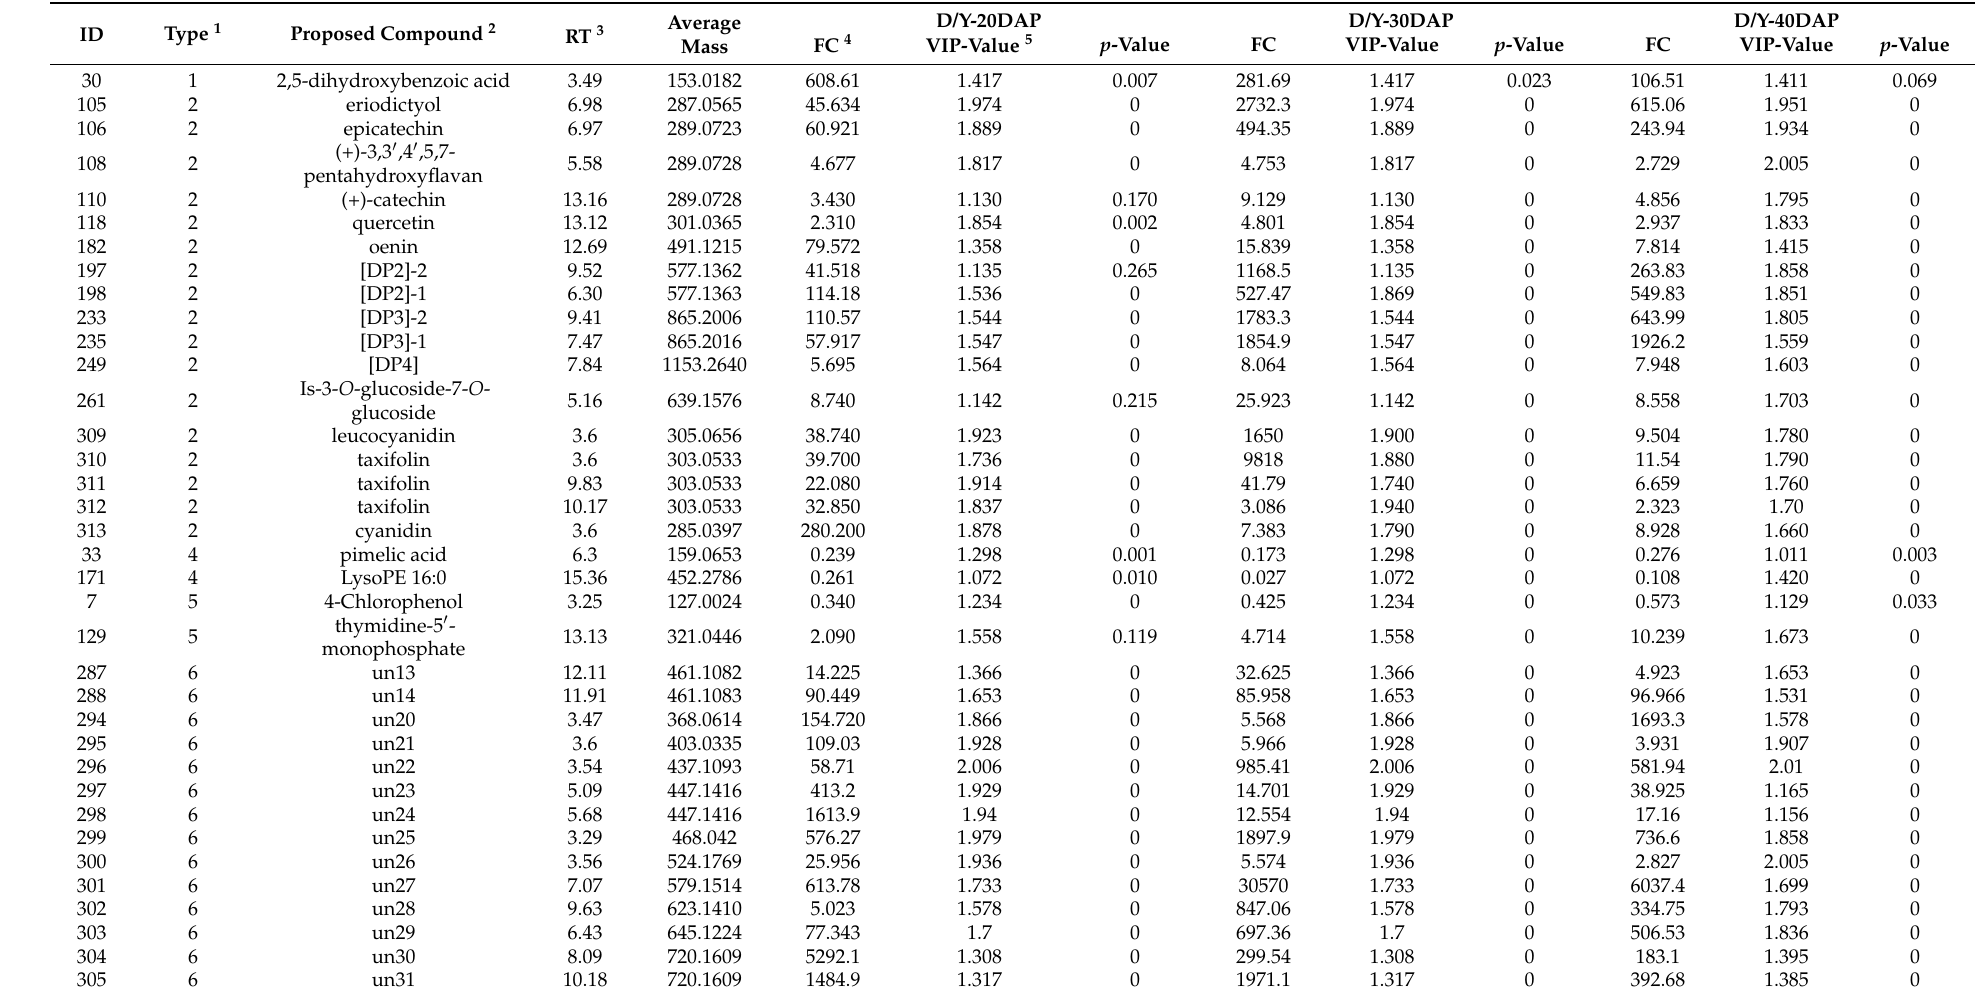
Table 1. Common differentially abundant metabolites in yellow- and dark-seeded B . juncea at three developmental